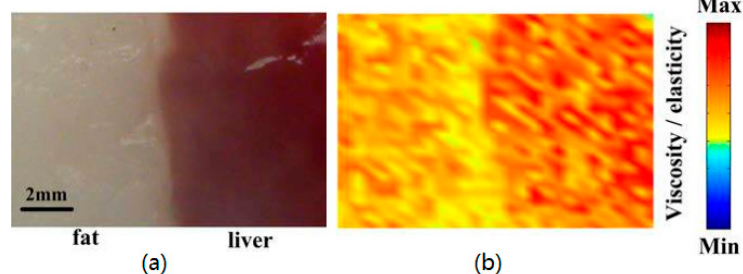
Figure 16. ( a ) Photograph of biological tissues (fat and liver). ( b ) Viscoelasticity distribution of the sample detected by PAVEI. Reproduced with permission from Ref. [96].